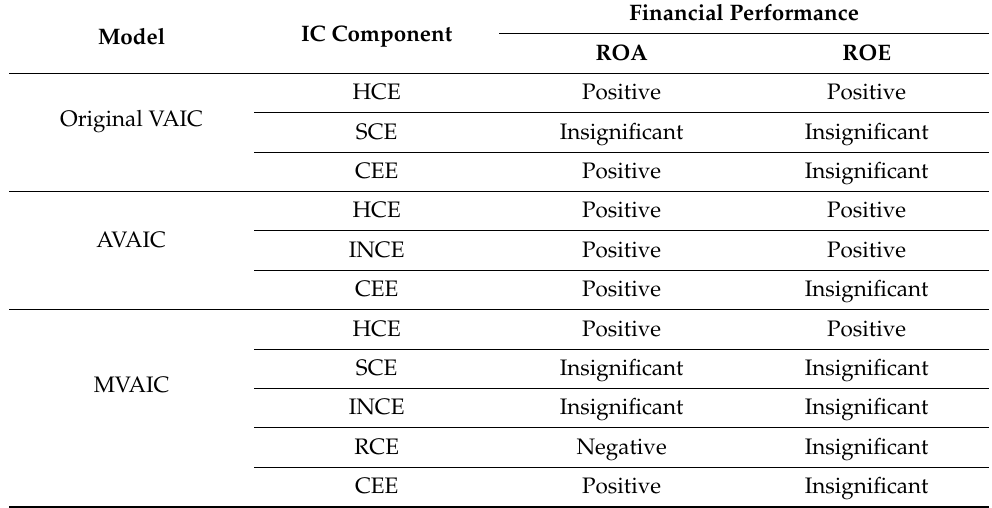
Table 12. Summary of three